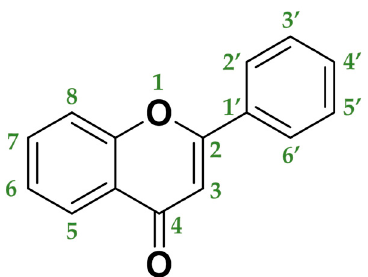
Figure 6. Molecular structure of flavone backbone.